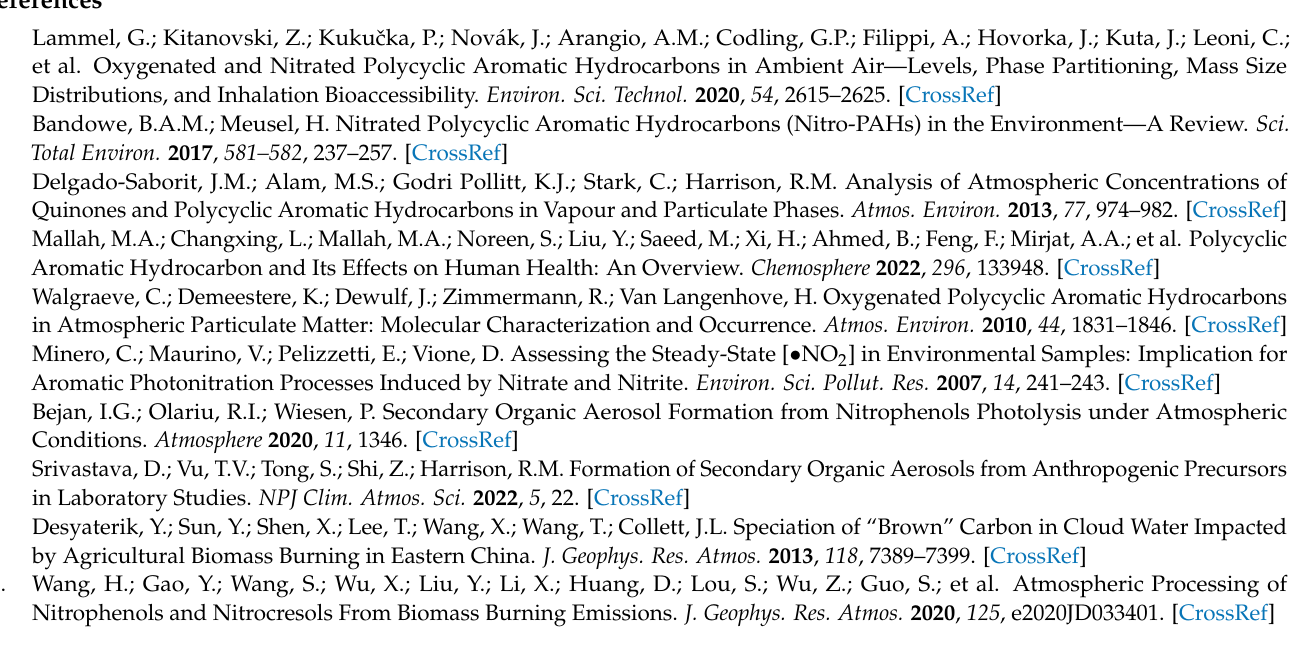
Tables S2–S4: Fourier coefficients; Table S5: Frequency list and residuals obtained with the XIAM and BELGI - C s - hyperfine programs; Table S6: Rotational constants of 4MNP-1 calculated at different levels of